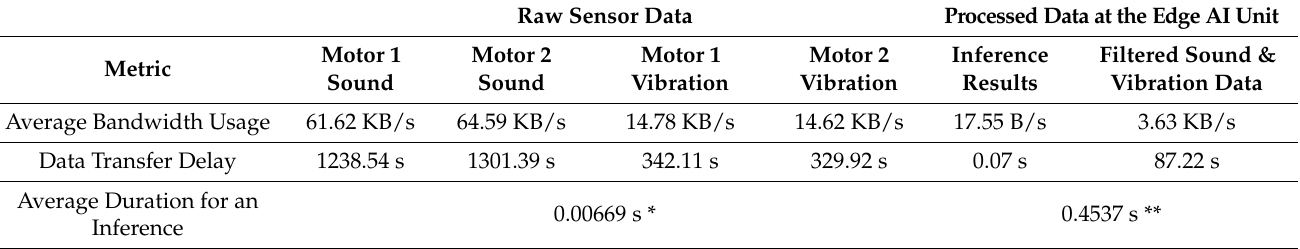
Table 1. Comparison of the metrics calculated from the raw sensor data and the processed data at the edge AI